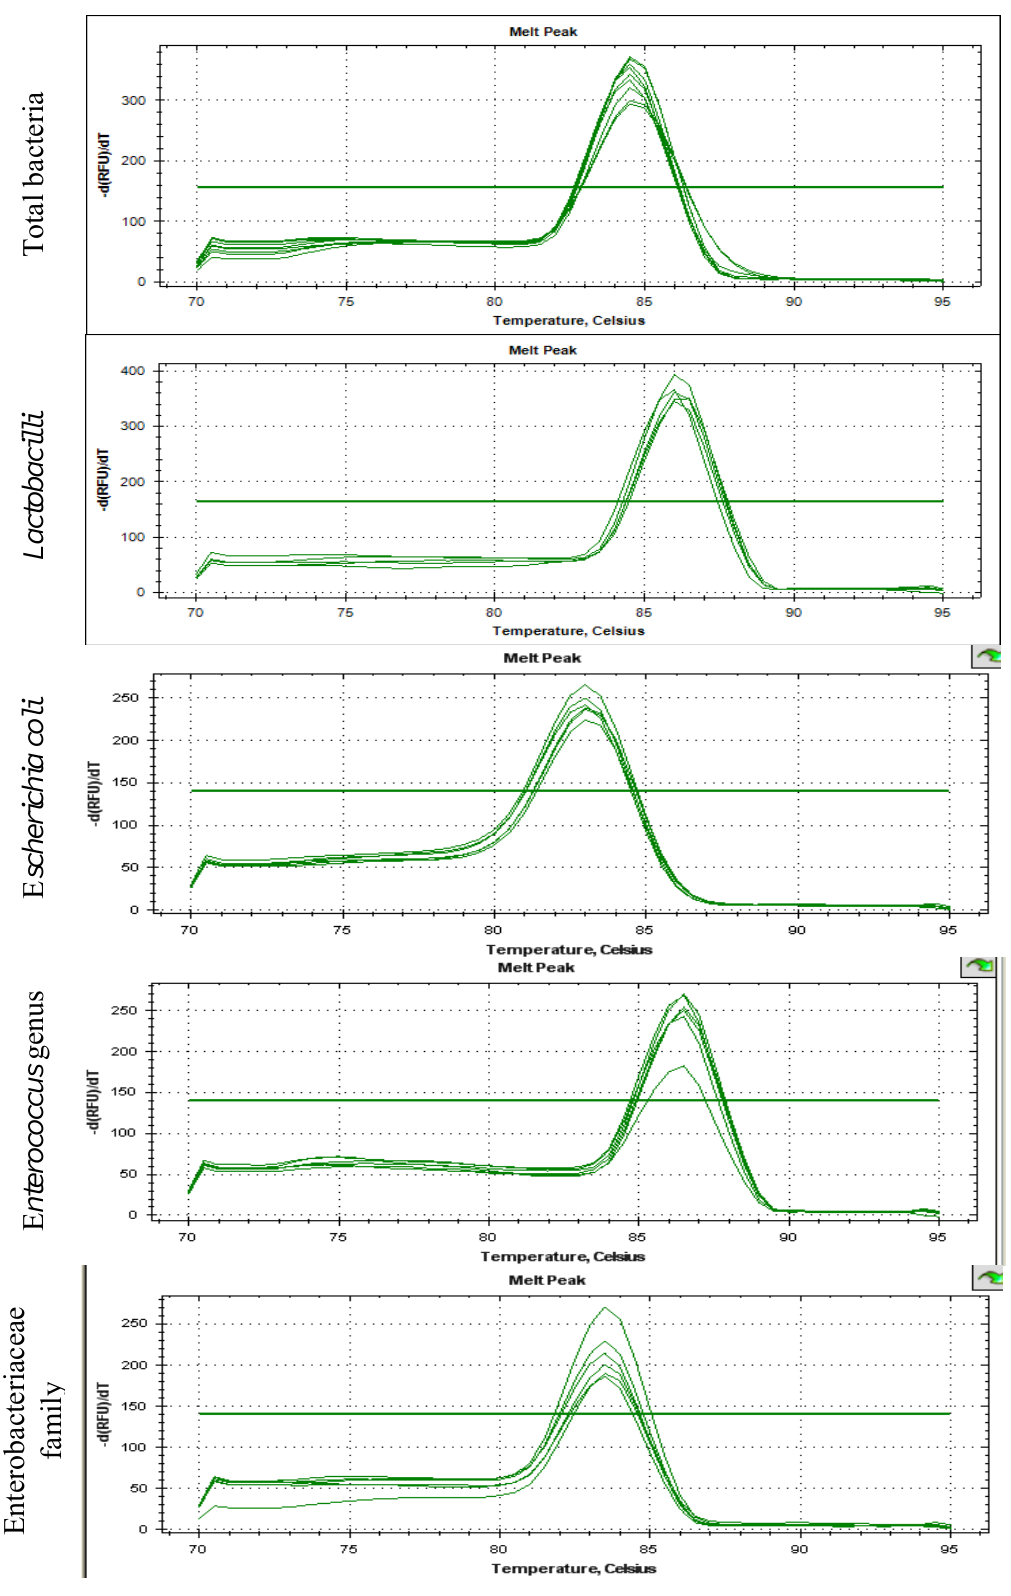
Figure 2. Melting curves for serial 10-fold diluted DNA of different bacterial